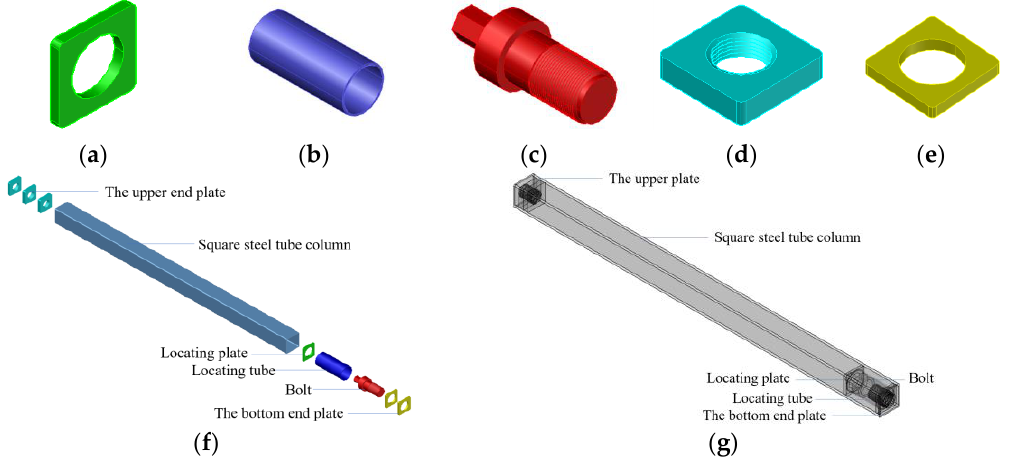
Figure 2. Diagram of the new connection structure. ( a ) Locating plate ( b ) locating tube ( c ) bolt ( d ) upper-end plate ( e ) bottom-end plate ( f ) assembly ( g ) assembly completed.